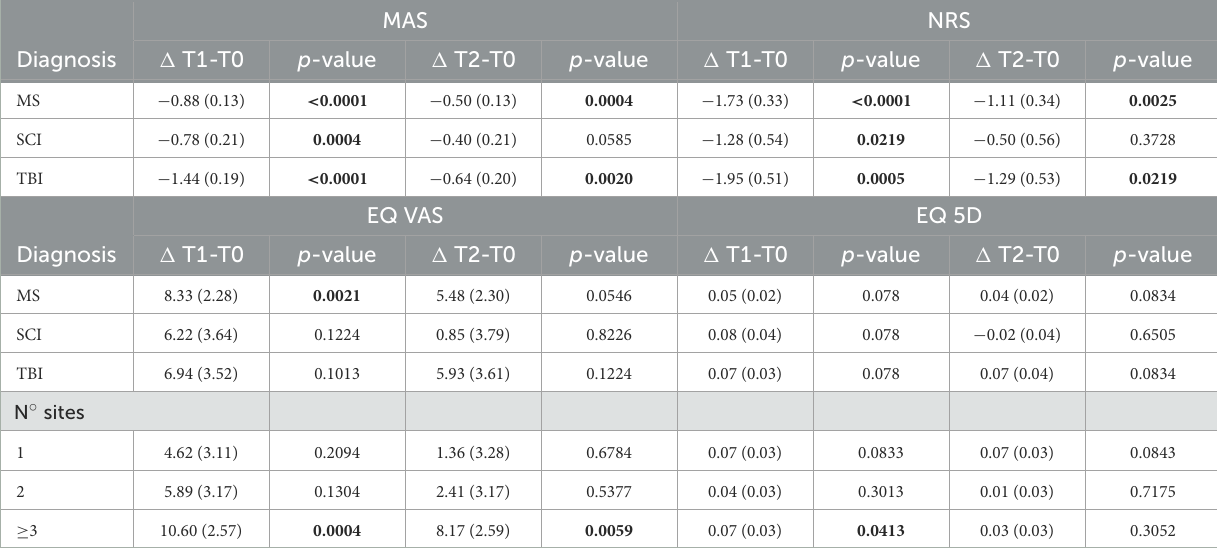
TABLE 3 Modification of variables’ mean values assessed with the false discovery rate (FDR) method, stratified per diagnosis and number of treated